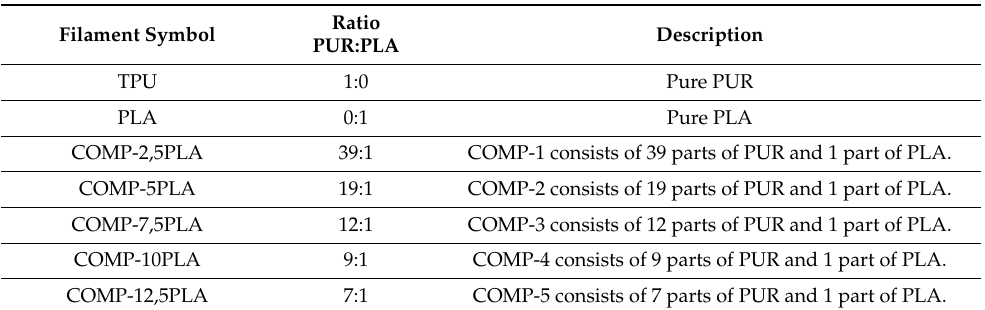
Table 1. Symbols of the obtained filaments with a brief explanation and materials’ ratios used for their